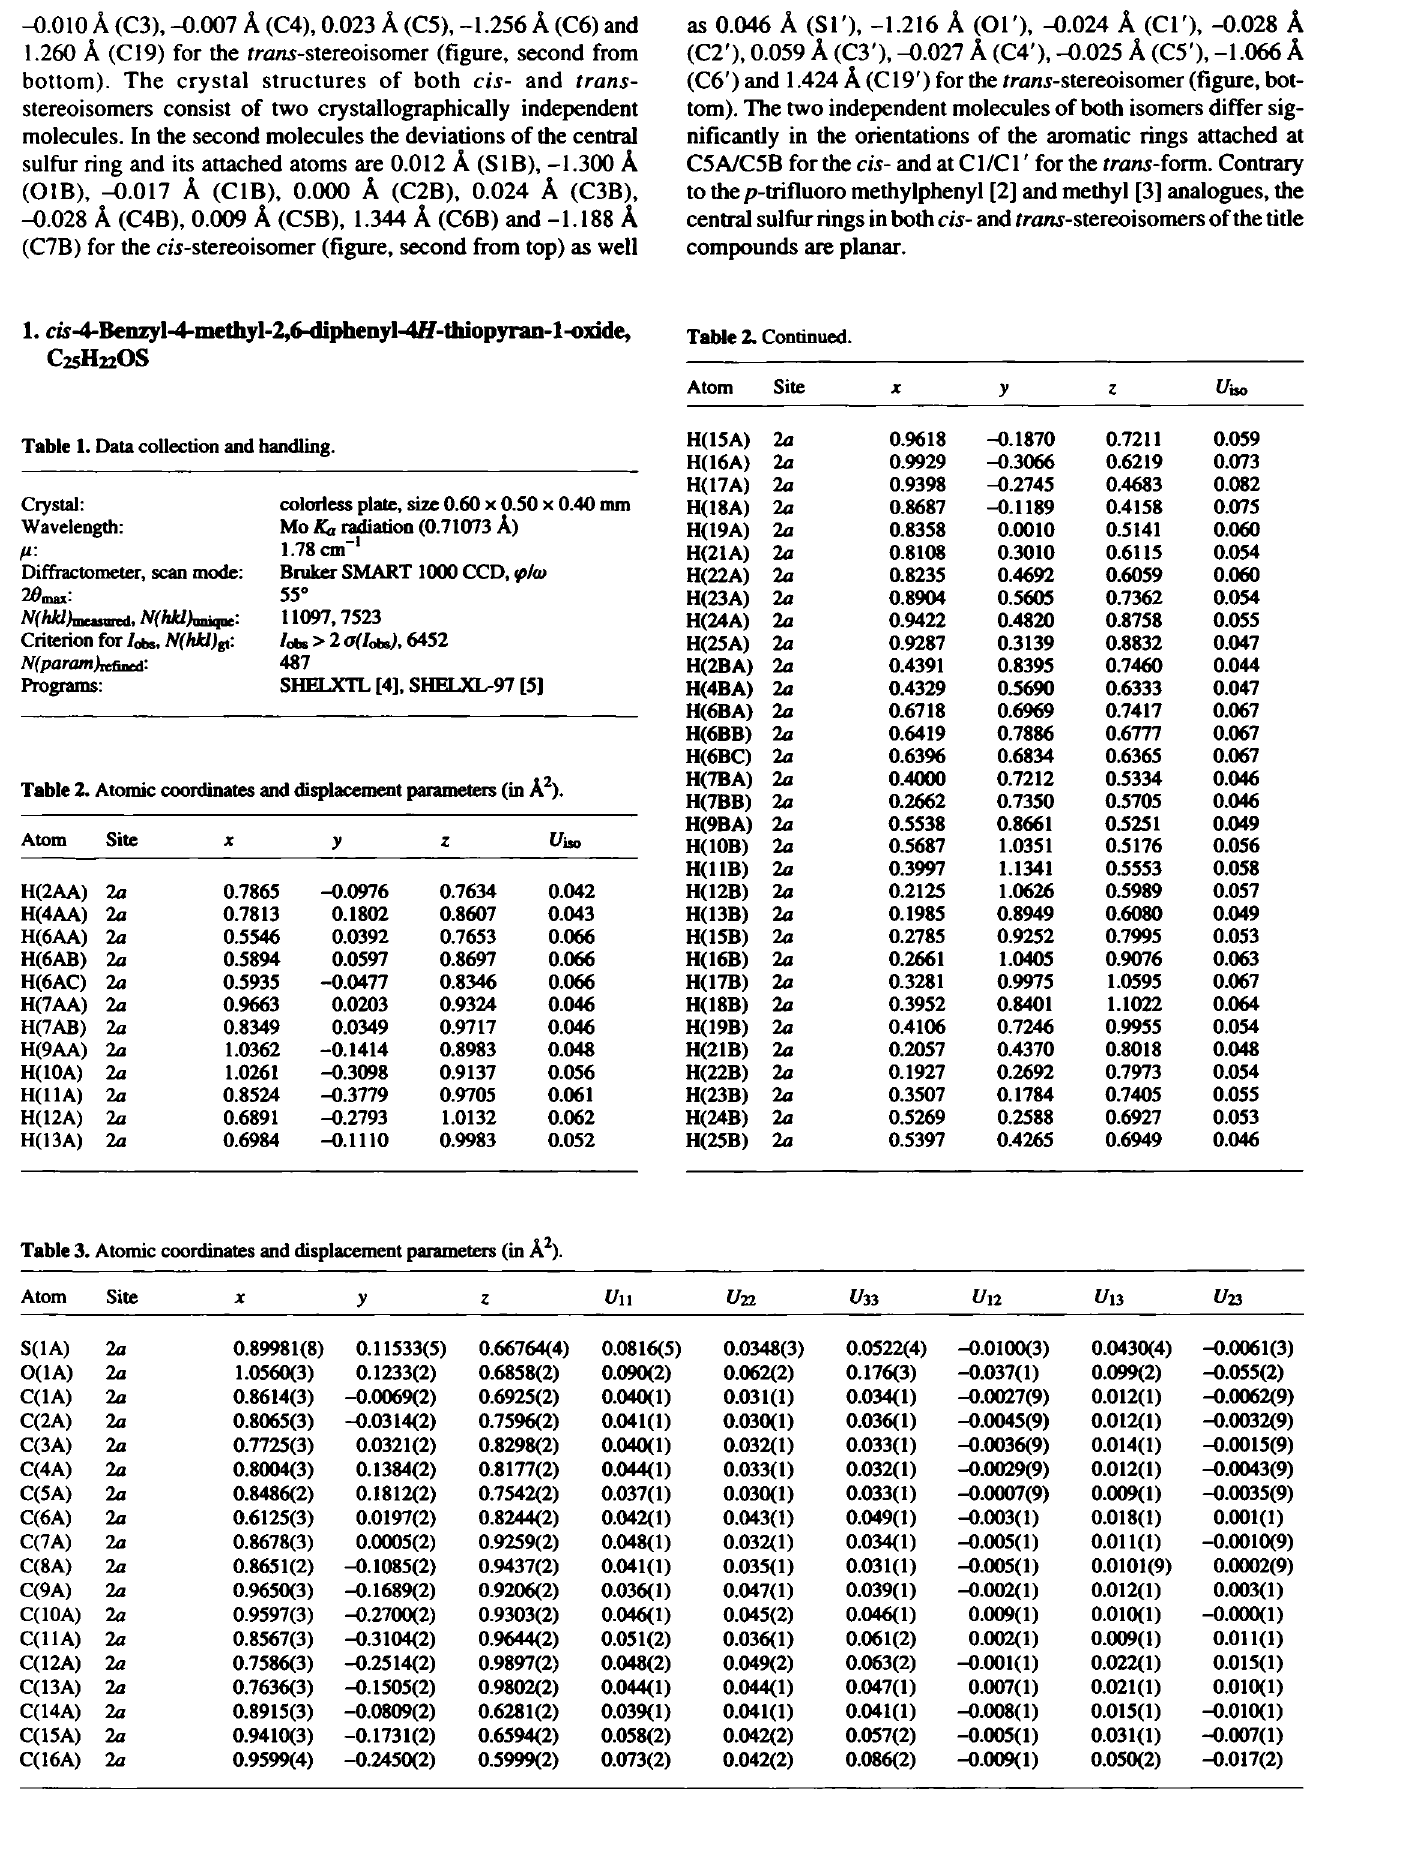
Table 3. Atomic coordinates and displacement parameters (in A 2